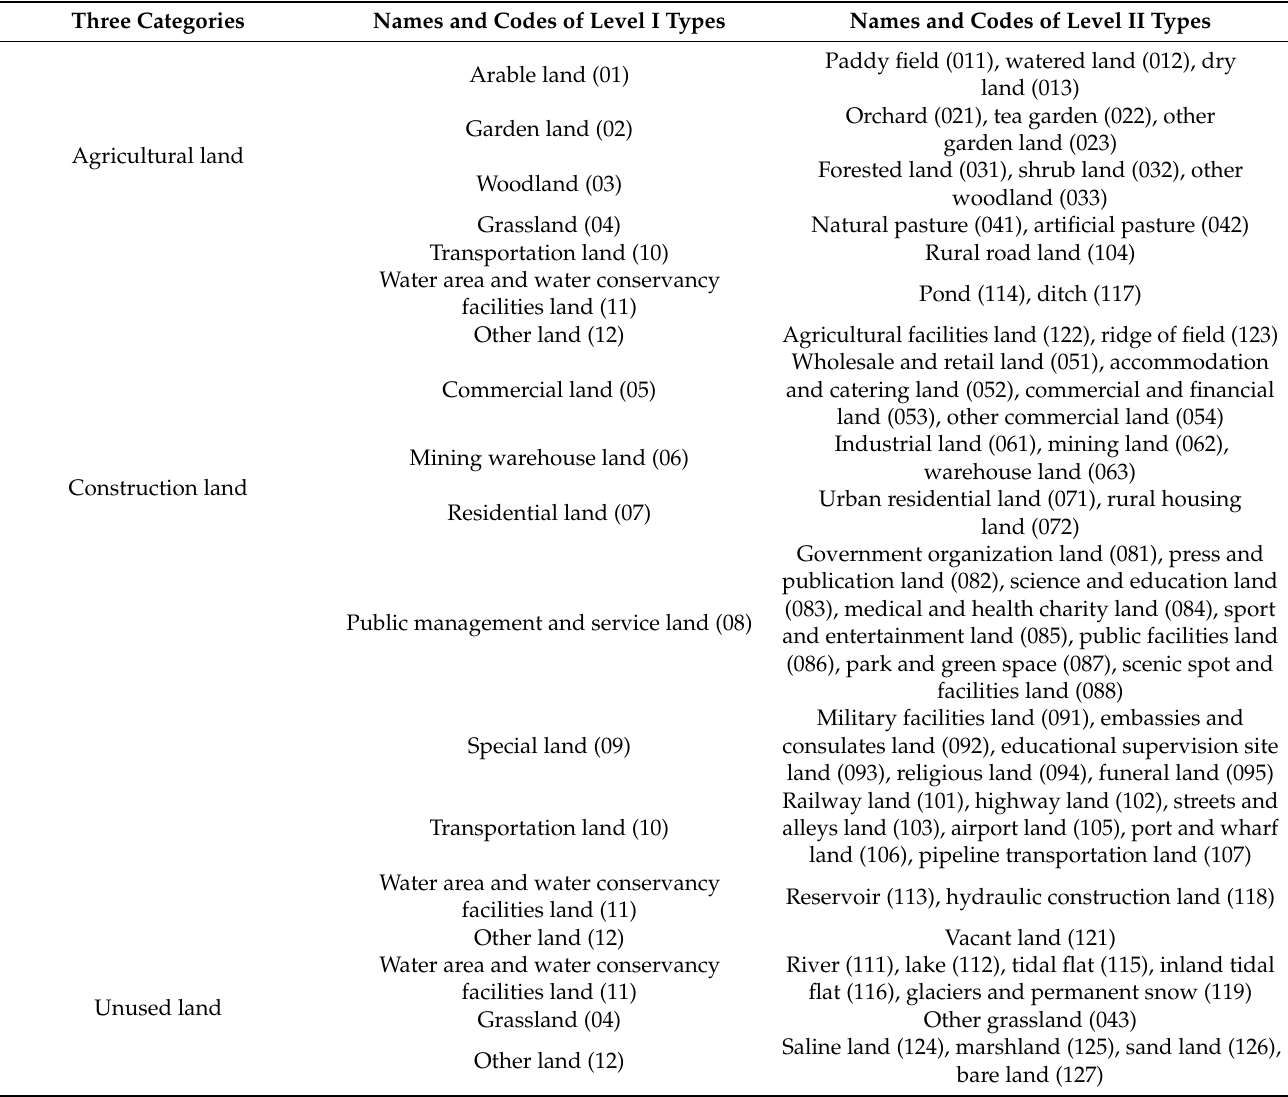
Table 2. The current land use classification and codes in China